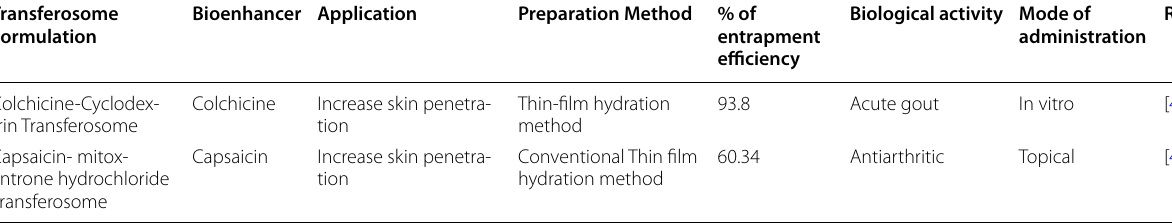
Table 4 Transferosome formulation containing natural bioenhancer Transferosome Formulation